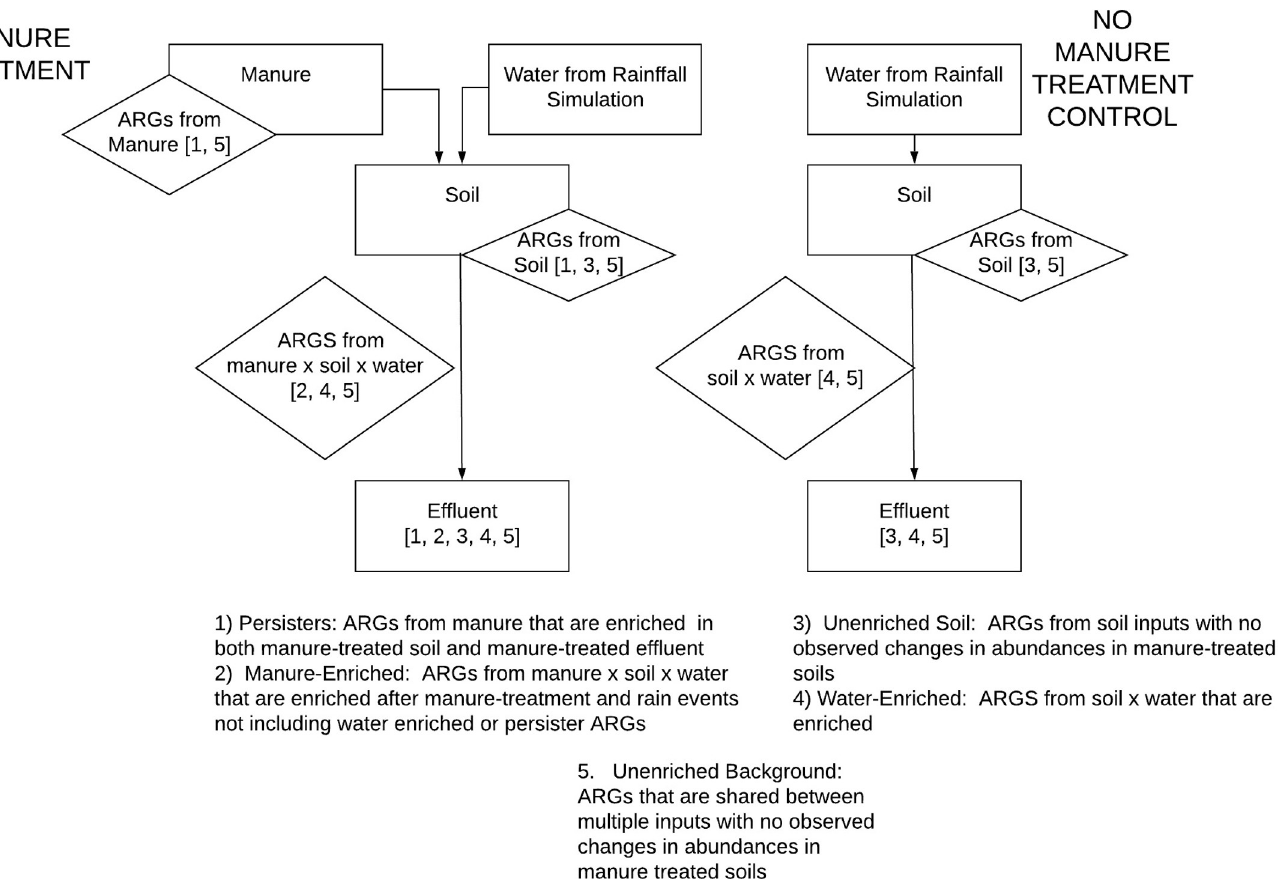
PLOS ONE | https://doi.org/10.1371/journal.pone.0222470 September 17,